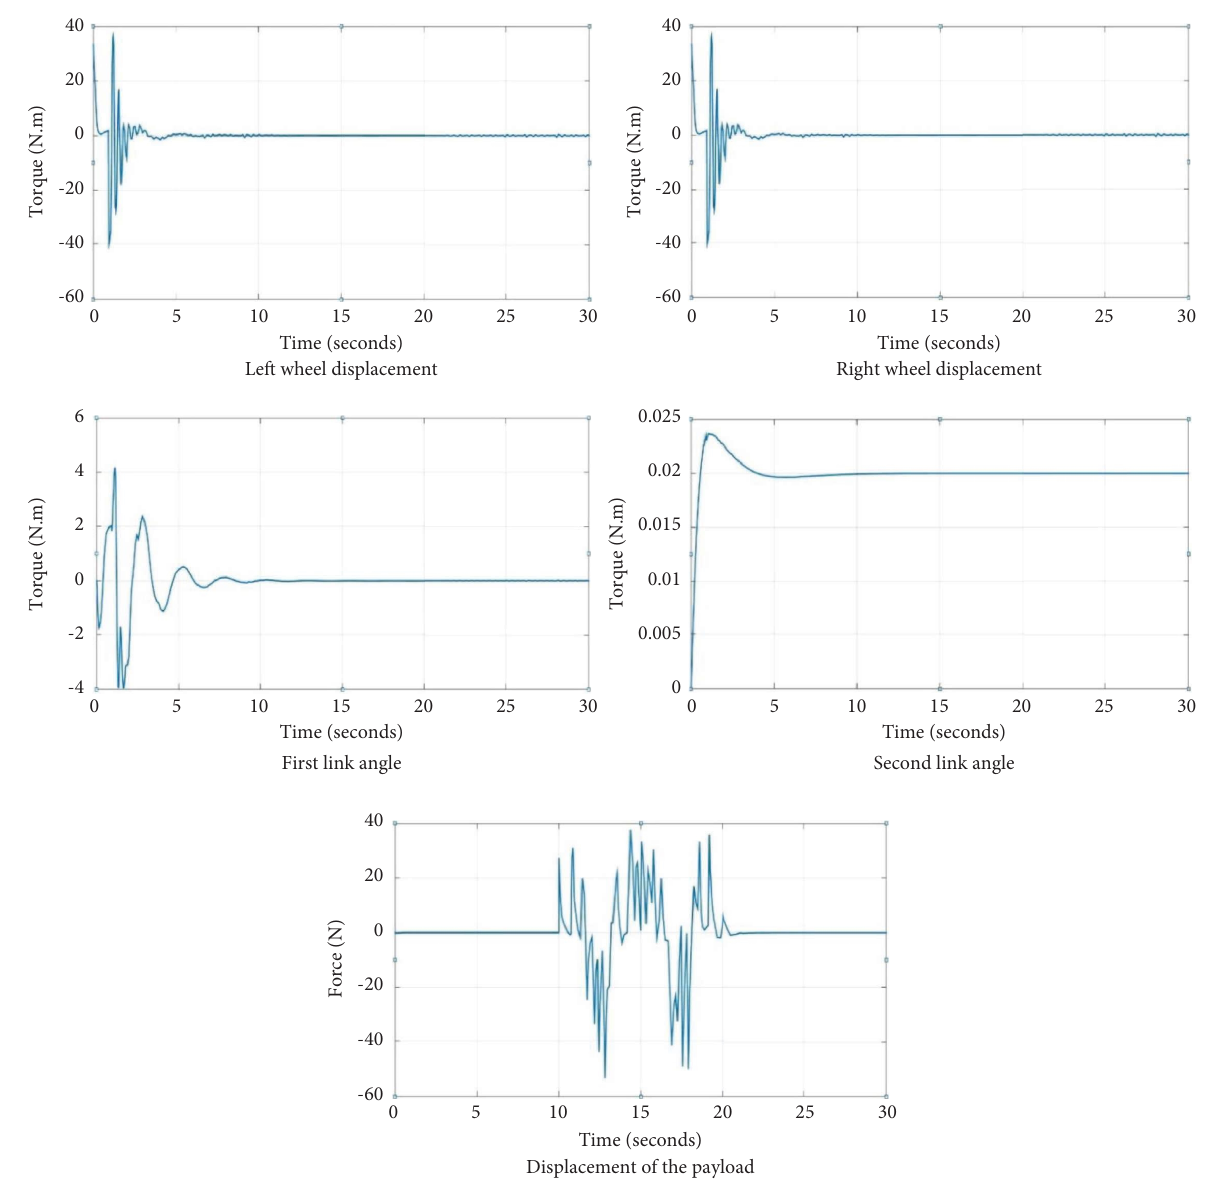
Figure 14: System exerted efort with the fourth input signal using hybrid